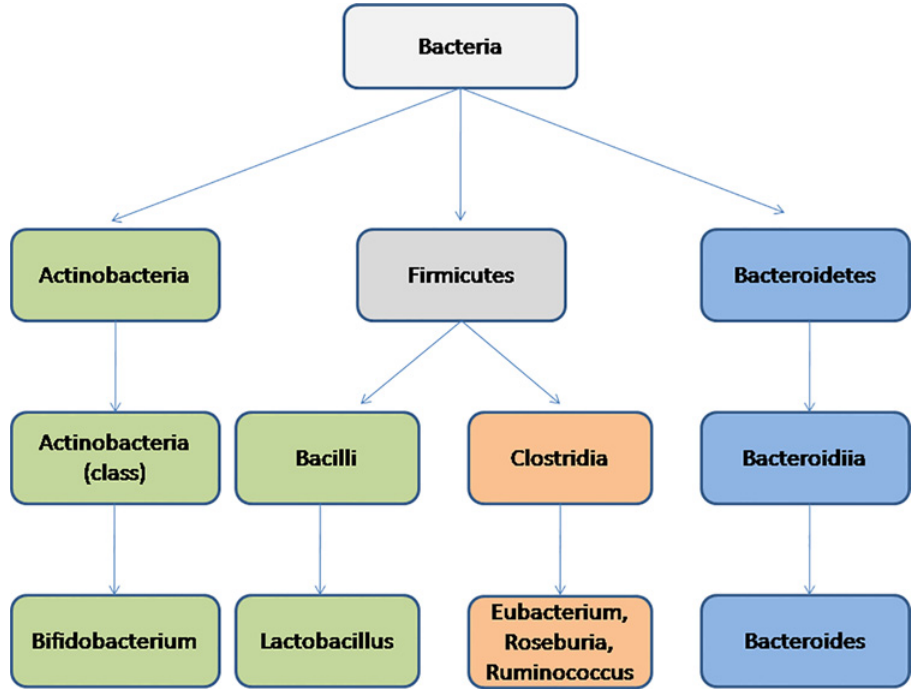
Fig 8. Taxonomic lineage of key drivers of the CAZotypes. Abundances of the different taxonomic lineages specific to the different CAZotypes. While CAZotype-1 is characterized by the over-representation of the genus Bacteroides lineage (phylum Bacteroidetes), CAZotype-2 has an over-representation of the genera Eubacterium, Ruminococcus and Roseburia (belonging to the Firmicutes phyla) and the genera